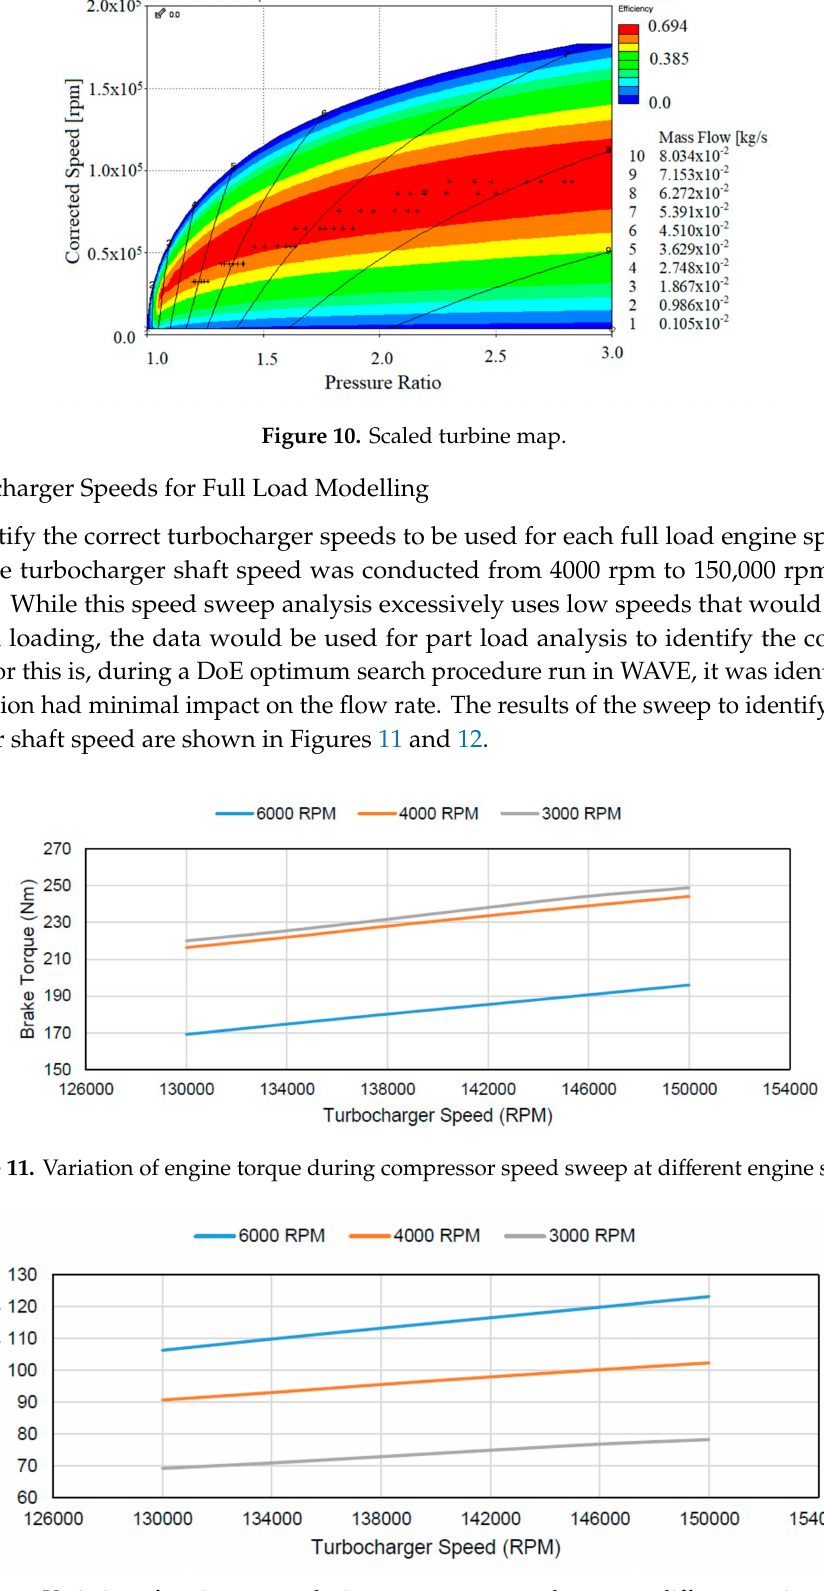
Figure 12. Variation of engine power during compressor speed sweep at di ff erent engine